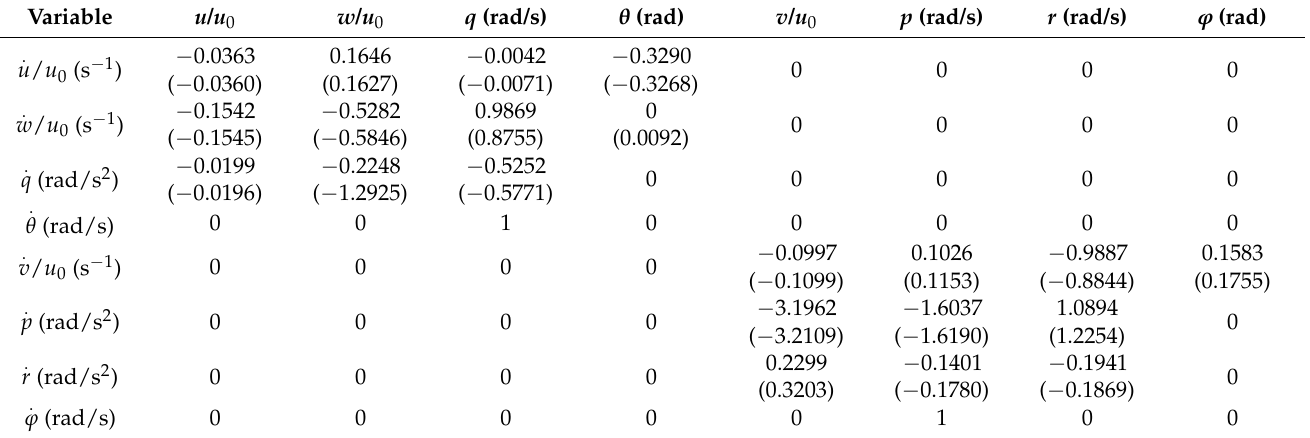
Table 14. CFD–RANS (extrapolated) 8 × 8 stability matrix for flight condition 7 in Tables 4 and 5.